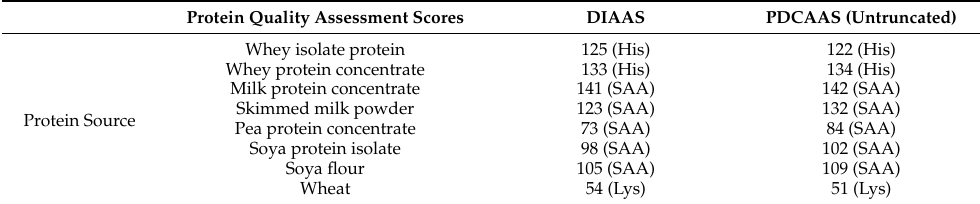
Table 4. Protein digestibility-corrected amino acid score (PDCAAS) and digestible indispensable amino acid score (DIAAS) values from dairy and plant proteins. The first-limiting amino acid is presented in